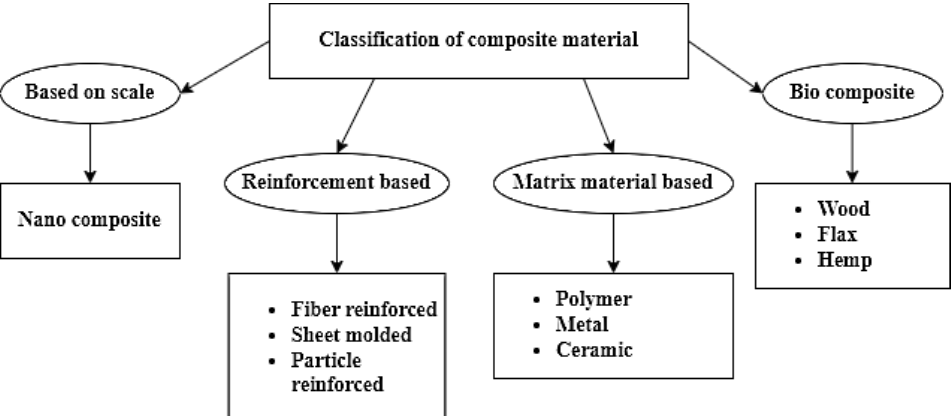
Figure 3. Detailed classification of composite materials.